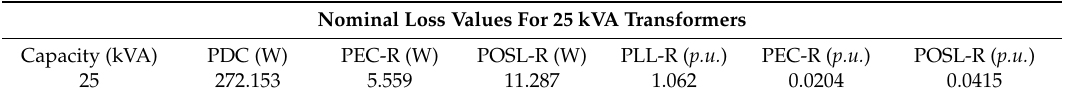
5 Source: INATRA Transformer Factory Test Protocol.